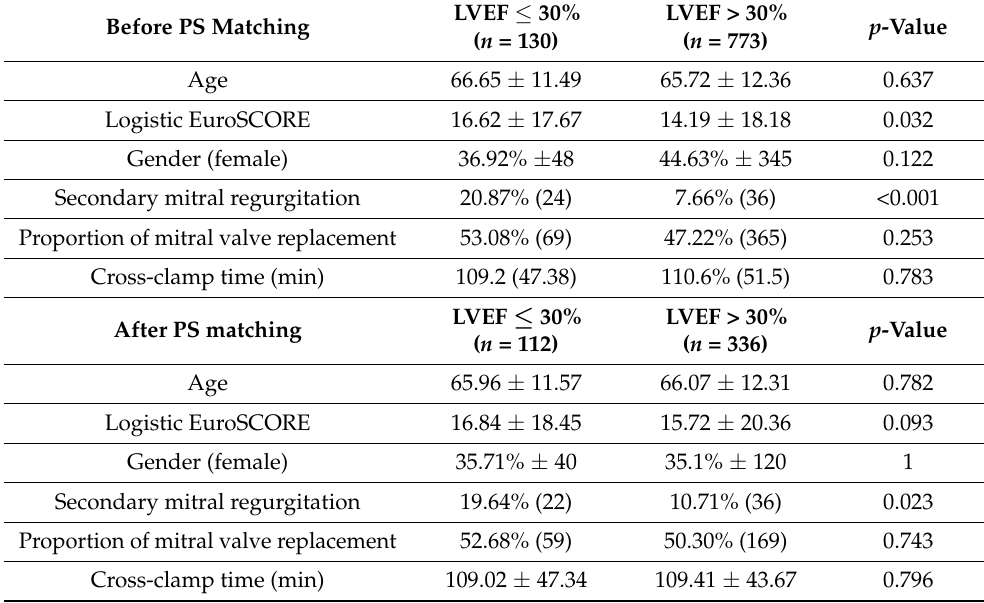
Table 1. Propensity score